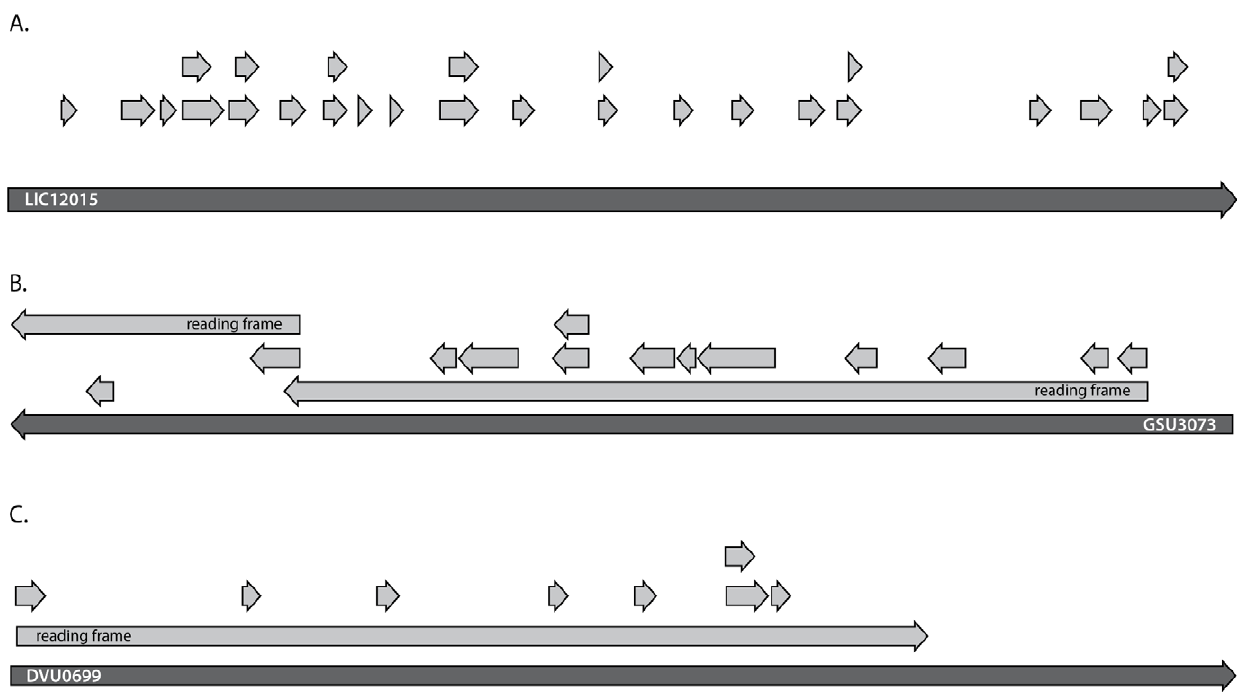
Figure 2. Classes of translated pseudogenes. Peptides (light grey arrows) are shown to map within pseudogene boundaries (dary grey arrows), proving that the region is translated to protein. A, peptides in a single coherent open reading frame spanning the entire length of the pseudogene LIC 12015 from Leptospira interrogans . It is unclear why such regions were designated as pseudogenes. B, peptides fall within two different translation frames which are located within Geobacter sulfurreducens pseudogene GSU3073. This situation can arise when the underlying genome sequence is erroneous and contains artificial indels, or if the two regions are separately translated. C, peptides fall in a single open reading frame which only partially covers the genomic regions annotated as a pseudogene, Desulfovibrio vulgaris pseudogene DVU0699. This confirms the conceptual translation of the pseudogene (i.e. ending in an in-frame non-sense codon).